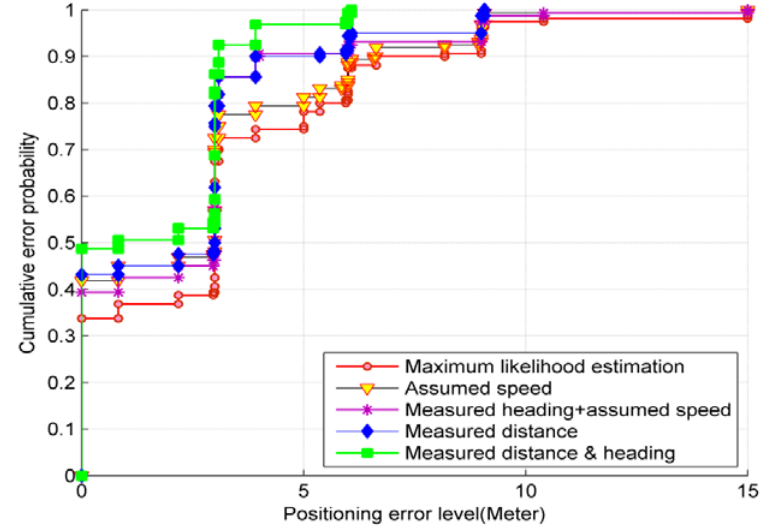
Figure 11. The cumulative probability distributions of the positioning errors related to the HMM solutions and the MLE solution. The HMM solutions use different combinations of MDI, as defined in Table 1, and utilize the grid-based filter algorithm to produce the position estimates.